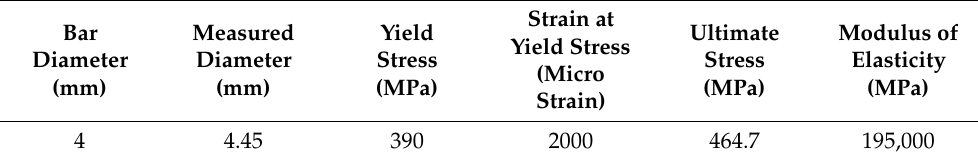
Table 2. The tensile test data of steel reinforcement.